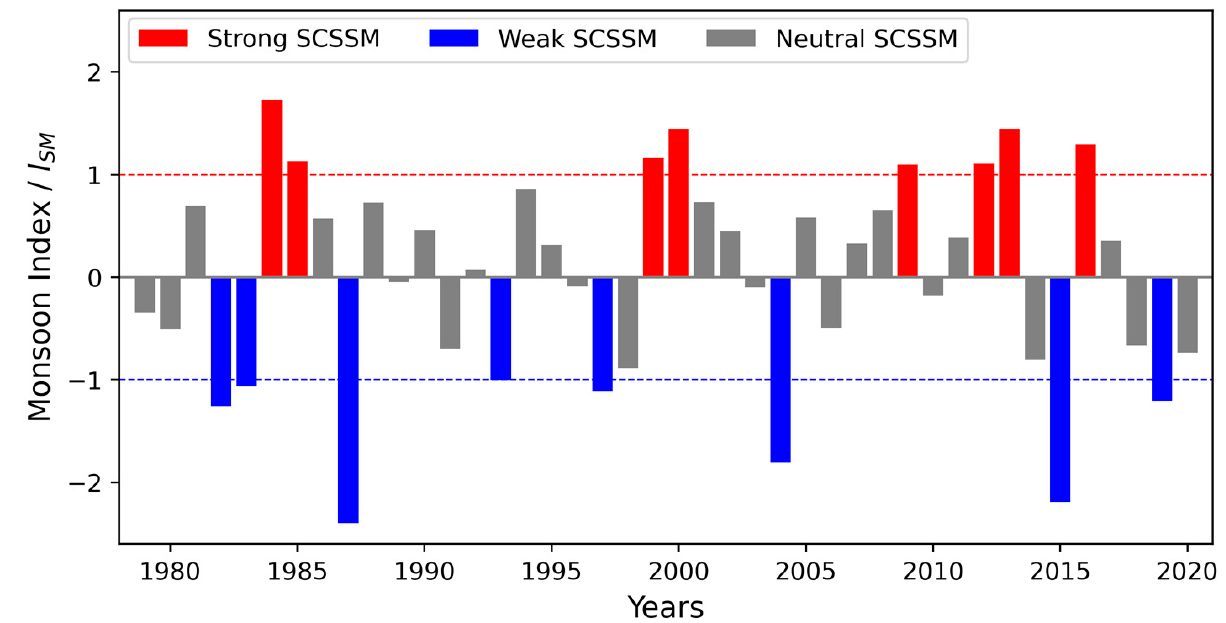
Figure 3. Time series of SCSSM intensity index ( I SM ) from 1979–2020. The red columns represent years with SCSSM activity exceeding one standard deviation, indicating anomalously strong years. The blue columns represent years with SCSSM activity below negative one standard deviation, indicating anomalously weak years.